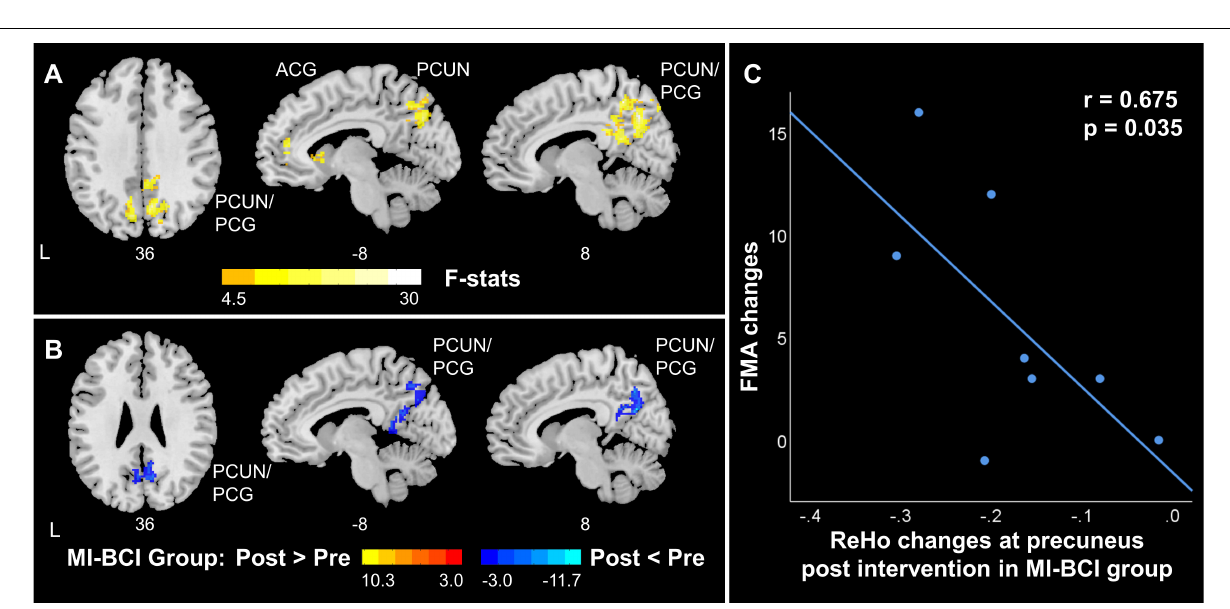
Frontiers in Human Neuroscience |